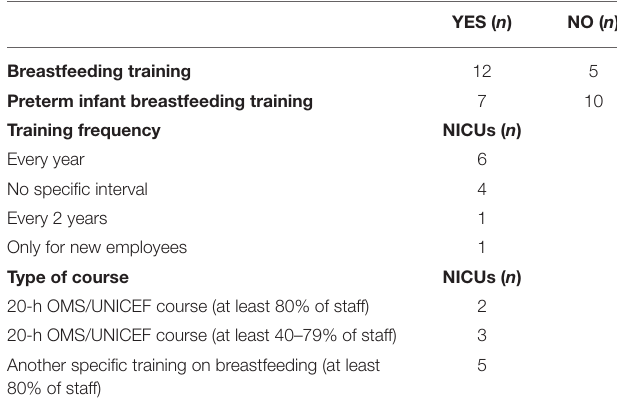
TABLE 5 | Staff training.